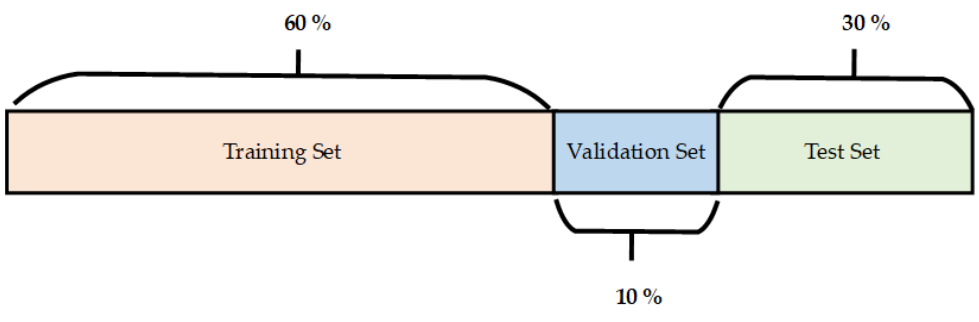
Figure 17. Division of the image dataset (training data, test data and validation data).